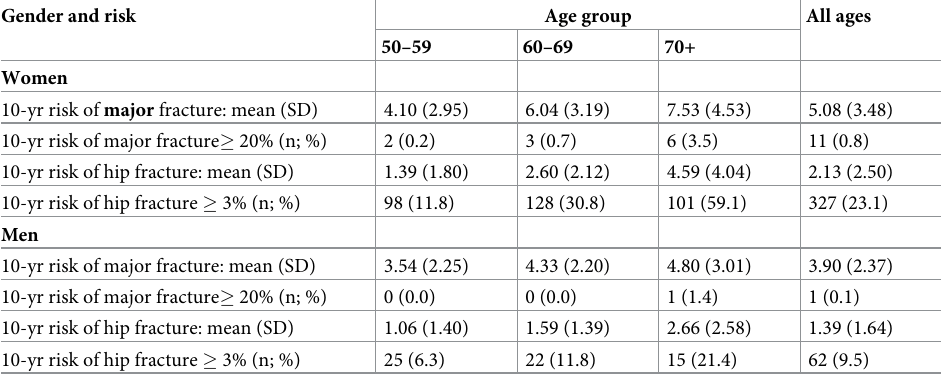
Table 2. Distribution of FRAX-estimated risk of fracture for men and women.